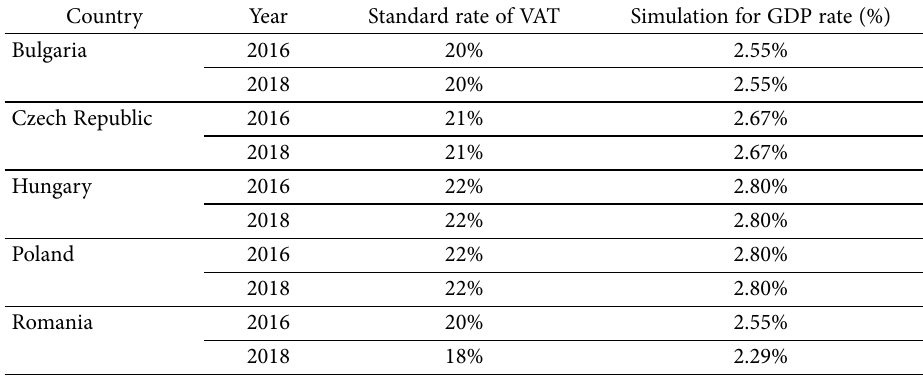
Table 5. Simulations of GDP rate in CEE-5 countries using random effects model Country Year Standard rate of VAT Simulation for GDP rate